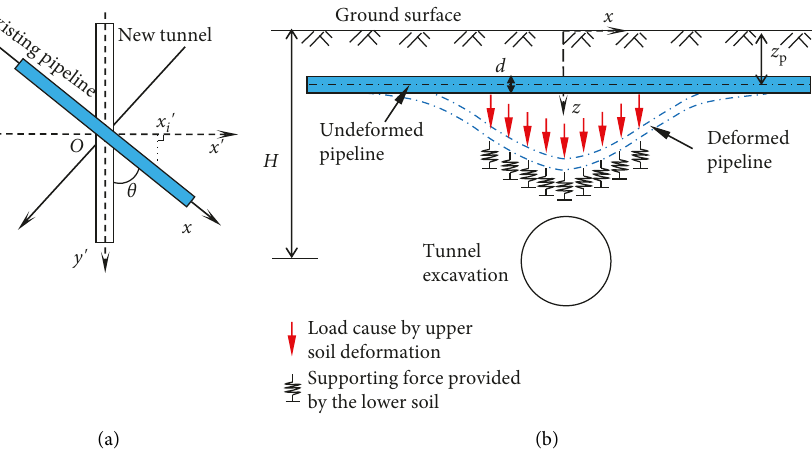
Figure 3: Deformation calculation diagram of pipeline during tunnel excavation. (a) Plan view. (b) Cross section view.